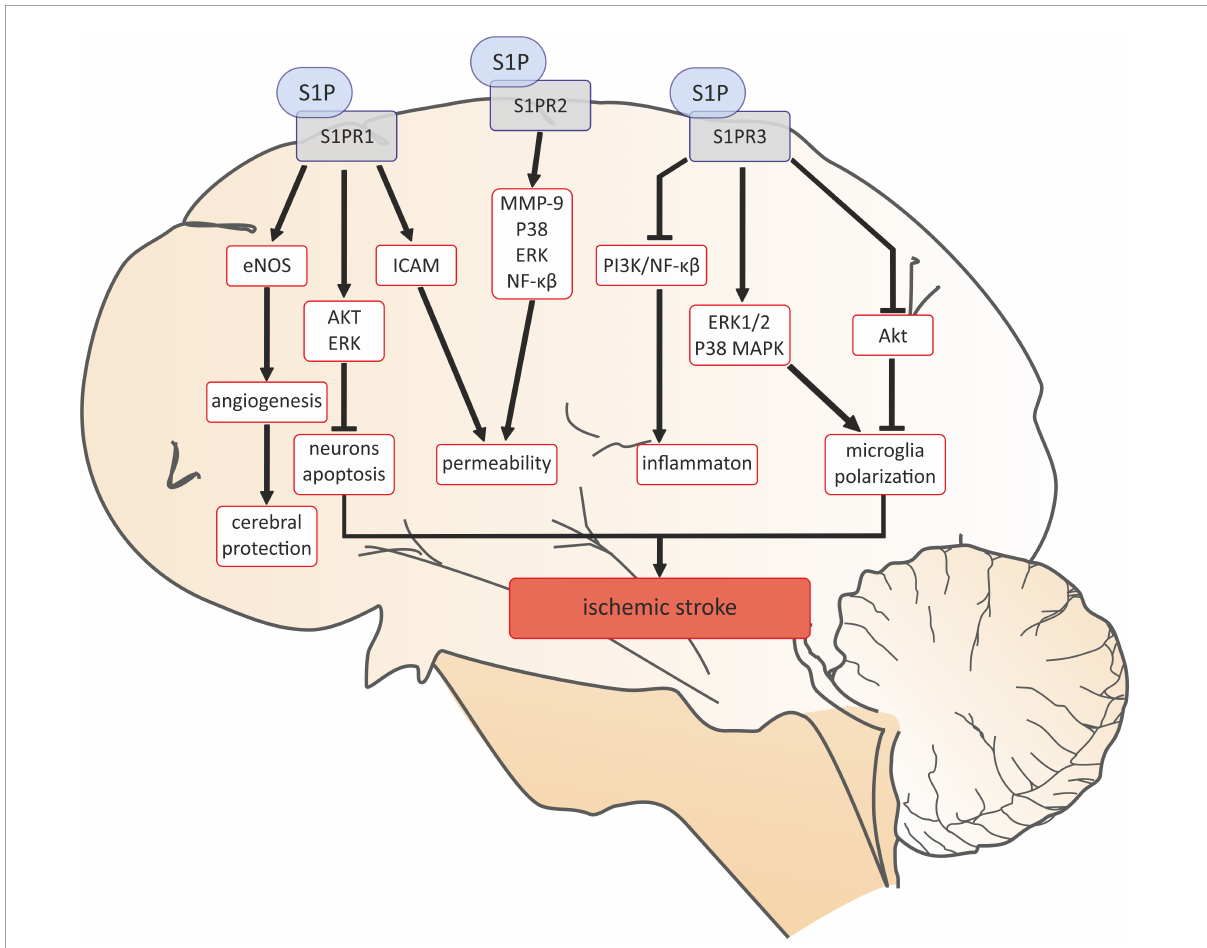
FIGURE5 Sphingosine 1-phosphate signaling in ischemic stroke. AKT, serine/threonine protein kinase B; eNOS, endothelial nitric oxide synthase; ERK, extracellular signal-regulated kinases; ERK1/2, Ras-dependent extracellular signal-regulated kinase; ICAM-1 -intercellular adhesion molecule 1; MMP-9, matrix metalloproteinase-9; NF- κ B, nuclear factor kappa-light-chain-enhancer of activated B cells; p38, p38 mitogen-activated protein kinases; PI3K, phosphoinositide 3-kinase; S1P, sphingosine-1-phosphate; S1PR1, sphingosine-1-phosphate receptor 1; S1PR2, sphingosine-1-phosphate receptor 2; S1PR3, sphingosine-1-phosphate receptor